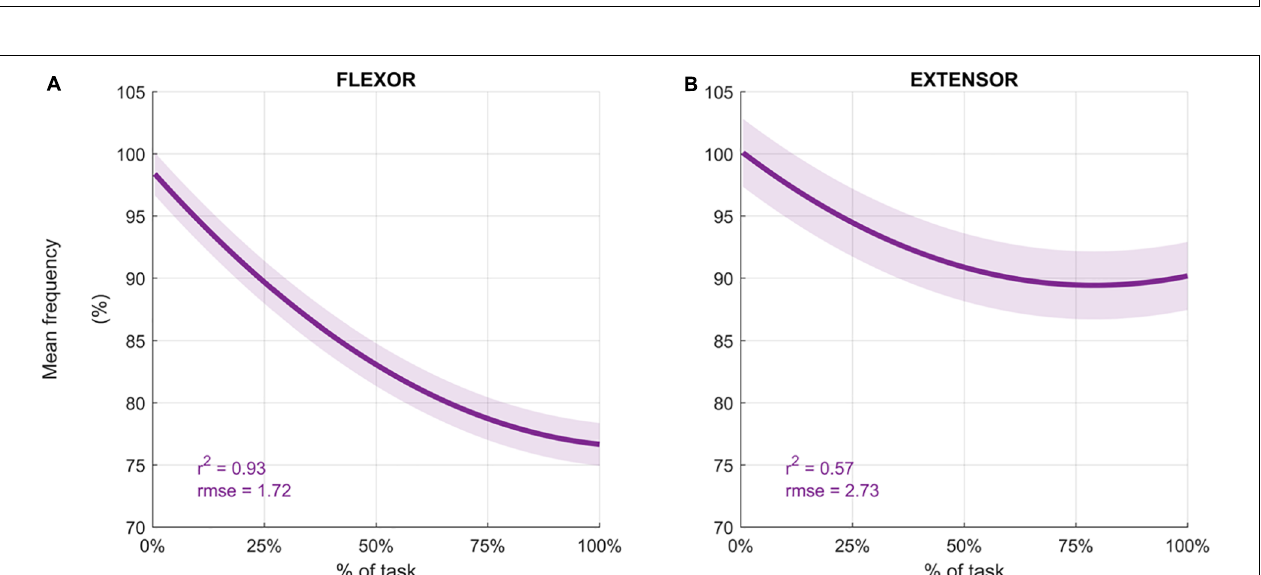
FIGURE 3 | Example of data segmentation. Kinematic data collected from robot encoders (A) where purple lines represent the end-effector trajectory (EE) along flexion-extension to reach the target (TGT) that moves between ± 48 ◦ (blue line). sEMG signal of flexor and extensor carpi radialis ( B , C , respectively) during the task, segmented into flexion and extension directions.